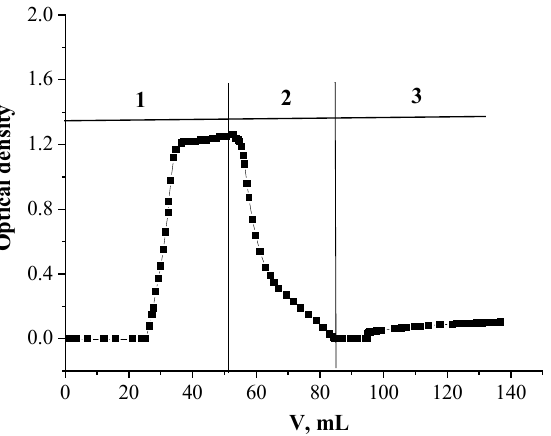
Figure 7. Extraction chromatography recovery of Nd(III) with SIR 4. 1 : adsorption of Nd(III) from HNO 3 of 0.001 mol/L; 2 : rinse of the column by HNO 3 with concentration of 0.01 mol/L; 3 : stripping of Nd(III) with distilled water.